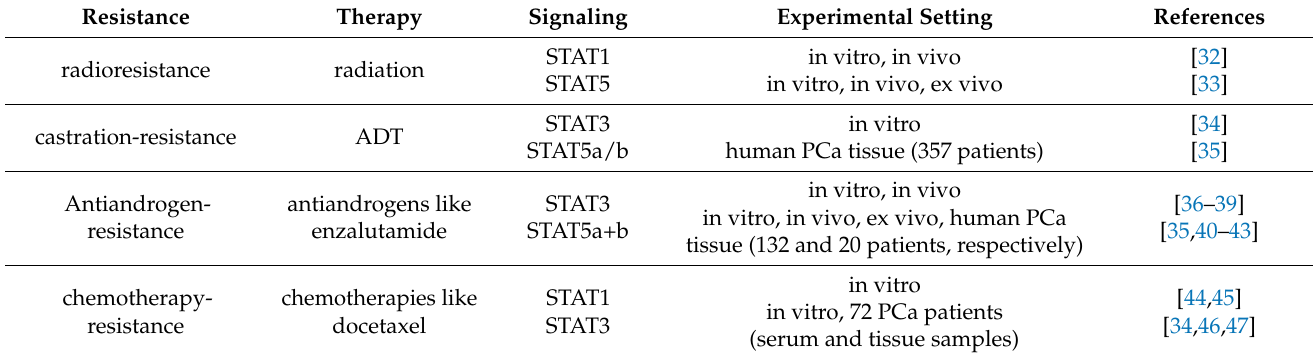
Table 1. STAT proteins in therapy resistance in